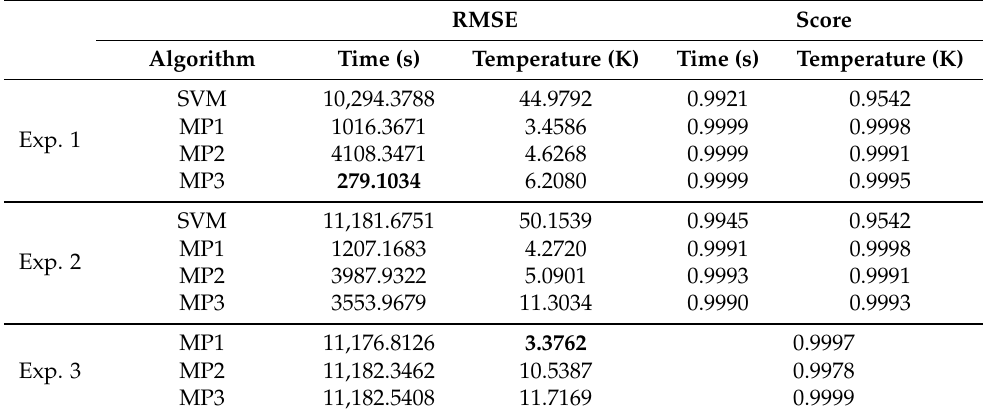
Table 4. RMSE of the predicted data compared to Thermo-Calc™ . The best option, with lower RMSE, was Exp. 1 (bold number), configured as MLP (three-layer)